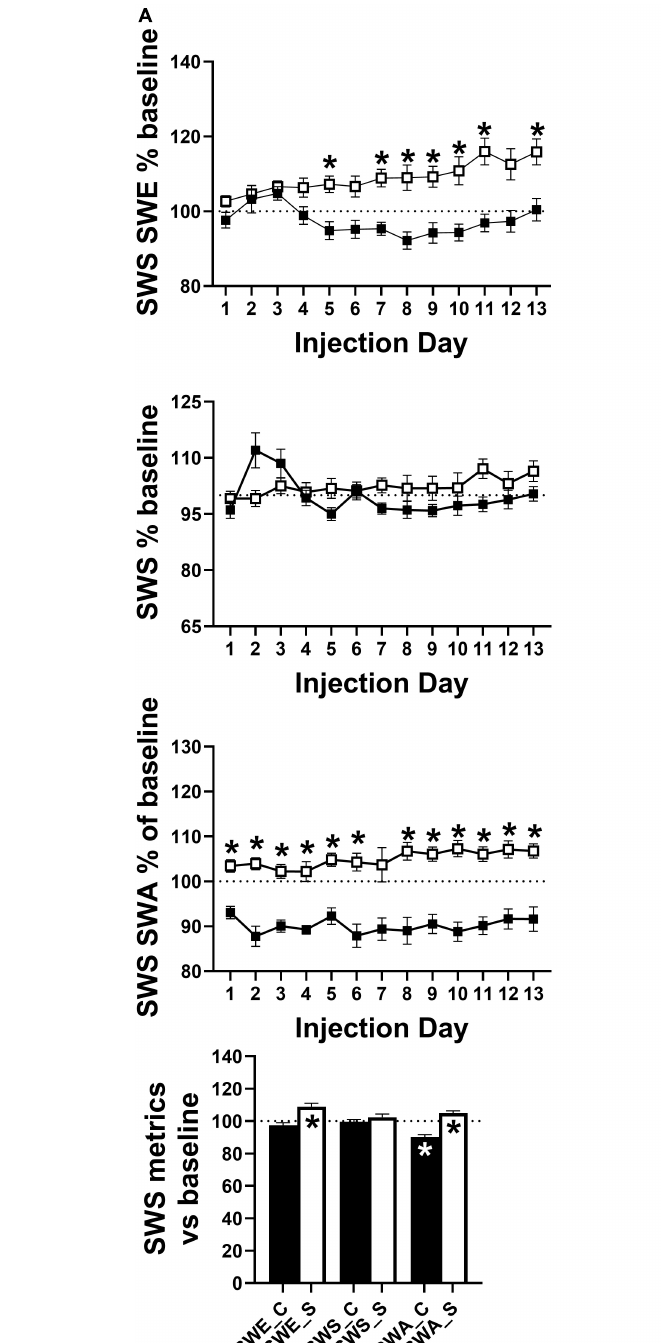
Frontiers in Neuroscience |